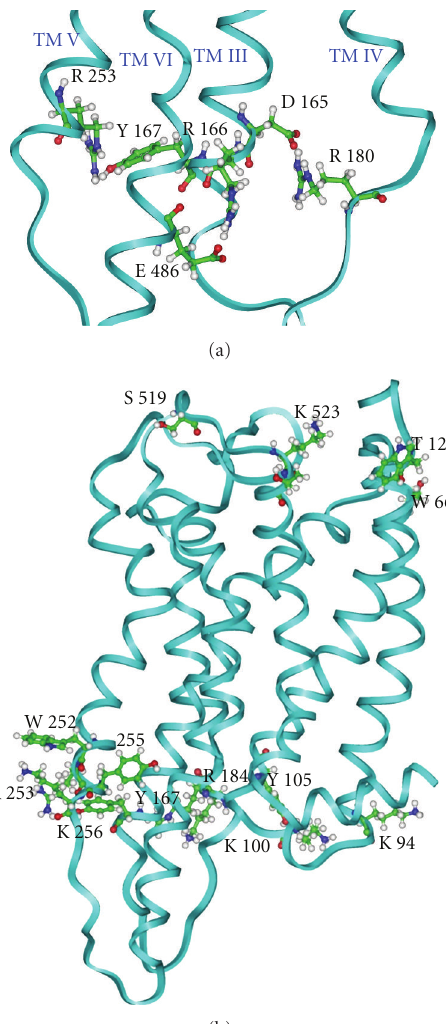
Figure 4: (a) Residues involved in the electrostatic lock between TM3 and TM6 helices in M3R. (b) Residues of M3R involved in hydrogen bonding with lipid oxygens. In bold are those residues have been also identified in a similar study in Rhodopsin (see